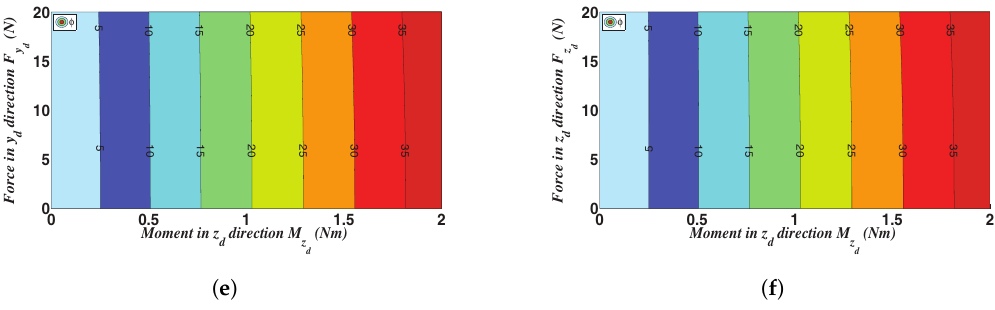
Figure A2. Contour plots of φ for all the loading cases: ( a ) moment, M x M x , and force, F z ; ( c ) moment, M y d d and force, F y ; ( f ) moment, M z d